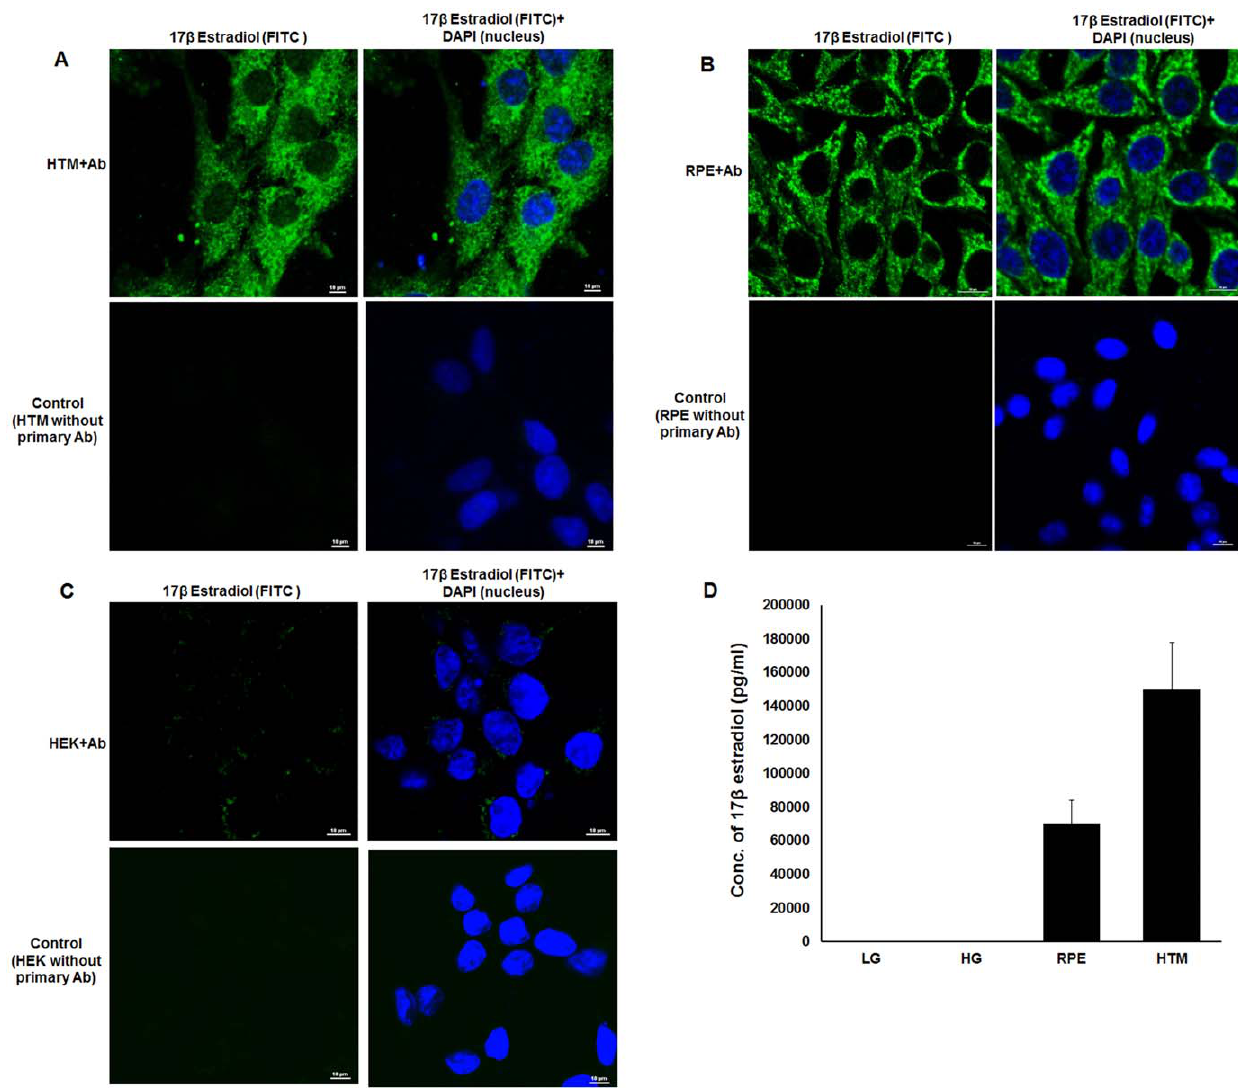
Figure 1. Presence of 17 b estradiol in ocular cells. Confocal images are shown for HTM ( Panel A ), RPE ( Panel B ) and HEK 293 ( Panel C ) cells using anti-17 b estradiol antibody and counterstained with FITC labeled secondary antibody. DAPI was used to stain the nucleus. In each panel control cells were treated only with FITC labeled secondary antibody, but not primary antibody, to assess the background noise. The scale of magnification is shown in each panel. The level of 17 b estradiol in HTM and RPE cell lines were estimated by ELISA ( Panel D ). Similar estimation in low glucose (LG) and high glucose (HG) media containing 10% charcoal treated FBS did not show presence of 17 b estradiol. The experiments were done in triplicate. tion of ER a , we intended to test the direct binding of ERs to the MYOC promoter element by chromatin immunoprecipitation (ChIP) assay. In HTM cells, treated with 1000 nM of 17 b - estradiol for 48 hrs, ChIP was done using anti-ER a antibody and the precipitated DNA was PCR amplified with primers specific to a 308 bp region of the MYOC promoter (Figure 6). Positive amplification of the specific region on MYOC promoter was observed in HTM cells treated with 17 b -estradiol indicating that ER a specifically binds to the EREs in the MYOC promoter and transactivates it. In order to further evaluate the specificity of the ChIP assay, a second PCR amplification was done with the same DNA sample immumoprecipitated with ER a antibody using primers specific to the Tyrosinase (TYR) promoter which is devoid of any putative ERE; absence of any PCR product strongly